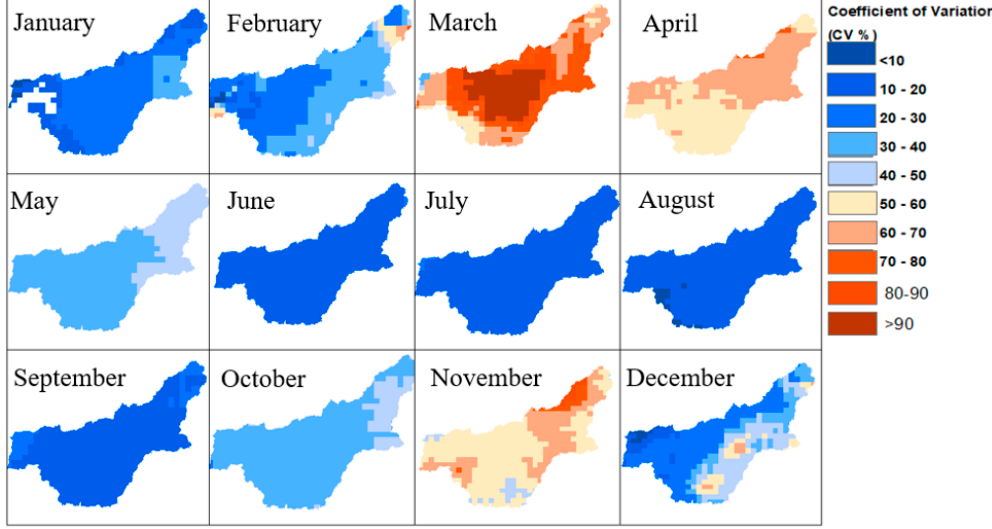
Figure 12. Monthly coefficient of variation of rainfall during the period 1981–2017.